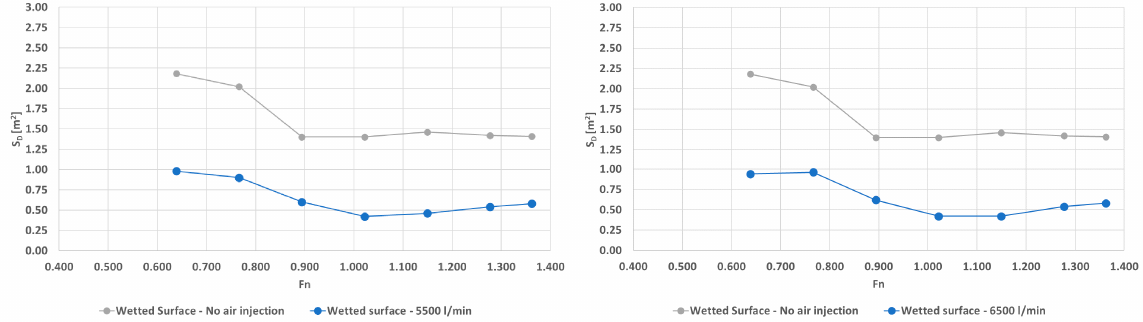
Figure 15. Wetted surface comparison–Air (5500 L/min and 6500 L/min) and No air.